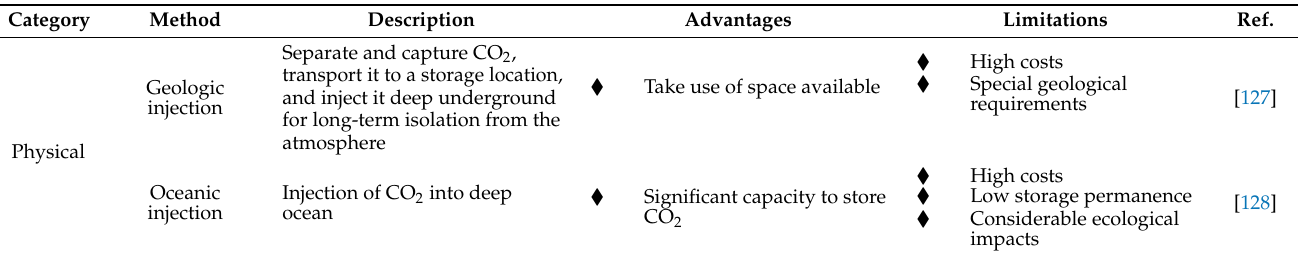
Table 4. Comparison of various carbon capture